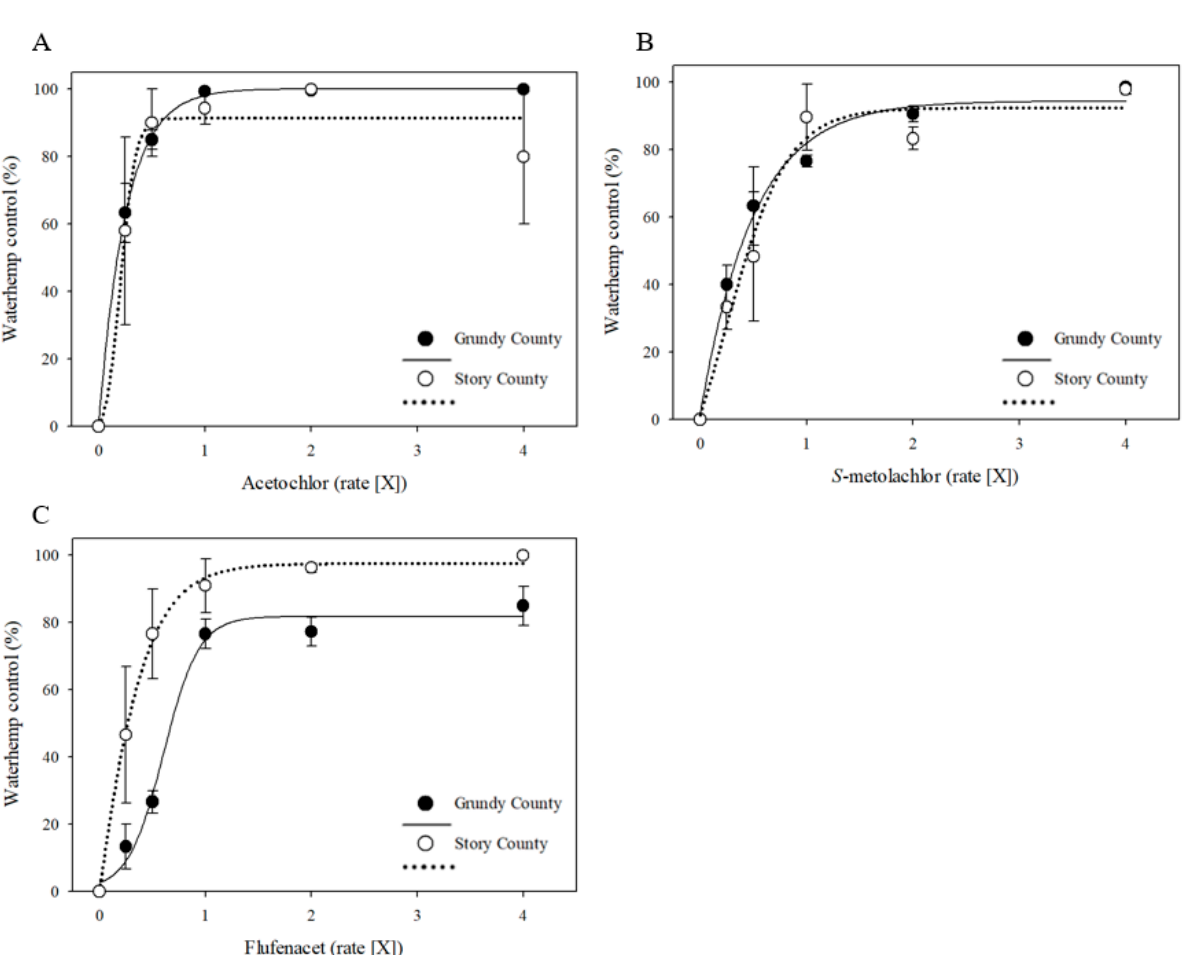
Figure 1. Waterhemp control with acetochlor ( A ), S -metolachlor ( B ), and flufenacet ( C ) applied at the multiplicative of the maximum labeled rate (X) on 4-way herbicide-resistant waterhemp populations from Grundy (2016) and Story County (2017), Iowa 28 days after crop emergence under field conditions. Herbicide and rate were significant effects ( p < 0.001) on waterhemp control, while the population was not ( p = 0.90). No significant interactions were detected. The lethal dose to control 50% of the plants (LD 50 ) and the lethal dose to control 90% of the plants (LD 90 ) for acetochlor was below the maximum labeled rate for both populations (LD 50 : Grundy County = 0.18x, Story County = 0.22x; LD 90 : Grundy County = 0.58x; Story County = 0.50x). The LD 50 for S -metolachlor was under the maximum labeled rate for both populations (Grundy County = 0.44x; Story County = 0.37x), while the LD 90 was above the maximum labeled rate (Grundy County = 1.35x; Story County = 1.53x), The LD 50 for flufenacet on the Grundy County population was under the maximum labeled rate (0.67x), but an LD 90 could not be calculated with the tested rates. The LD 50 and LD 90 for flufenacet on the Story County population was below the maximum labeled rate (LD 50 = 0.26x; LD 90 = 0.82x). The rates needed to achieve the LD 50 and LD 90 were calculated from 4-parameter sigmodal curves. Acetochlor: Grundy County = − 13365 + 13465 / (1 + exp ( − (X + 1.24)/0.25)), r 2 = 0.99; Story County = − 4.9 + 93.6/(1 + exp ( − (X–0.2)/0.07)), r 2 = 0.97. S -metolachlor: Grundy County = 7 − 9674 + 79769/(1 + exp( − (X + 3.3)/0.5)), r 2 = 0.98; Story County = − 38.6 + 131/(1 + exp( − (X + 0.2)/0.3)), r 2 = 0.93. Flufenacet: Grundy County = 0.6 + 81.2/( − (X + 0.6)/0.2)), r 2 = 0.97; Story County = − 202.8 + 300.4/( − (X + 0.2)/0.34)), r 2 = 0.99. The results of germination chamber dose–response assay reject the null hypothesis as four- and five-way herbicide-resistant waterhemp populations exhibited decreased susceptibility to acetochlor and S -metolachlor. However, in the field assay, there was a failure to reject the null hypothesis as all tested VLCFA-inhibiting herbicides applied at the maximum labeled rate provided the same control (>80%) on the MHR waterhemp